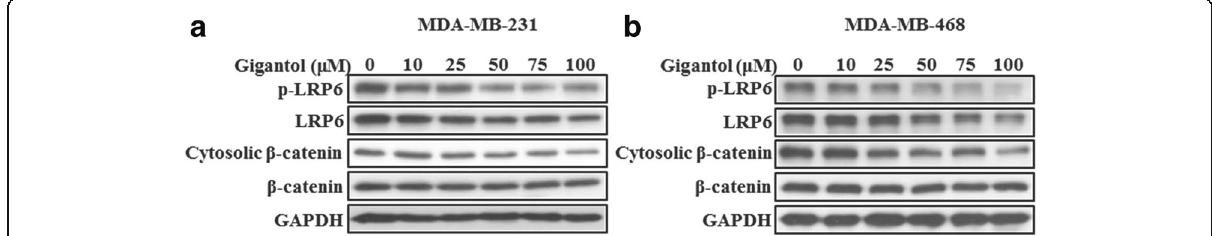
Fig. 4 Gigantol suppresses Wnt/ β -catenin signaling pathway in breast cancer cells. a-b MDA-MB-231 ( a ) and MDA-MB-468 ( b ) cells were treated with the indicated concentrations of gigantol for 24 h. Phosphorylated LRP6, total LRP6, cytosolic β -catenin, and total β -catenin were detected by